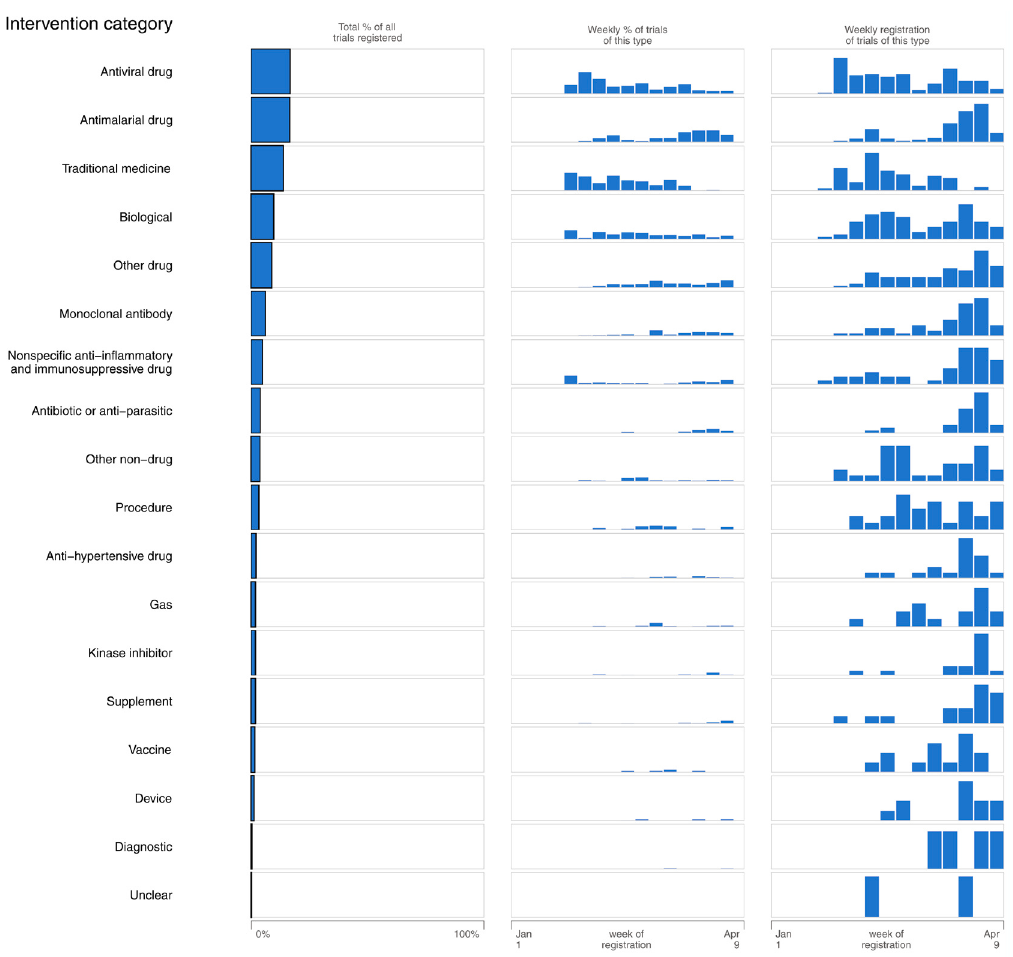
Figure 1. Number of trials assessing the different intervention categories. Interventions for treatment assessed in more than 25 trial: antiviral drugs were assessed in 141 trials; (e.g. lopinavir/ritonavir [n=45]), antimalarial drugs in 111 trials; (e.g. hydroxychloroquine [n=84]), monoclonal antibodies in 51 trials (e.g. tocilizumab [n=25]), traditional medicine in 106 trials, other drug intervention in 70 trials, nonspecific anti-inflammatory/immunosuppressive drugs in 42 trials (e.g. colchicine [n=4]), antibiotic/anti-parasitic drugs in 34 trials (e.g. azithromycin [n=28]), biologicals in 80 trials (e.g. convalescent plasma [n=27]), procedures in 28 trials (e.g. renal replacement therapy [n=4]), other non-drug interventions in 267 trials (e.g. physical activity). More information can be found in the Extended data 12 . The first column represents the proportion of all trials that were of the specified type. The second column represents the proportion of all trials registered that week that were of the specified type (i.e. within week, between trial types). The third column represents the distribution of when trials of this type were registered (i.e. within trial type, between week), and can be interpreted as either a percentage or count (not specified). A trial might assess more than one intervention category and detail for prevention and treatment trials are given in the extended data 12